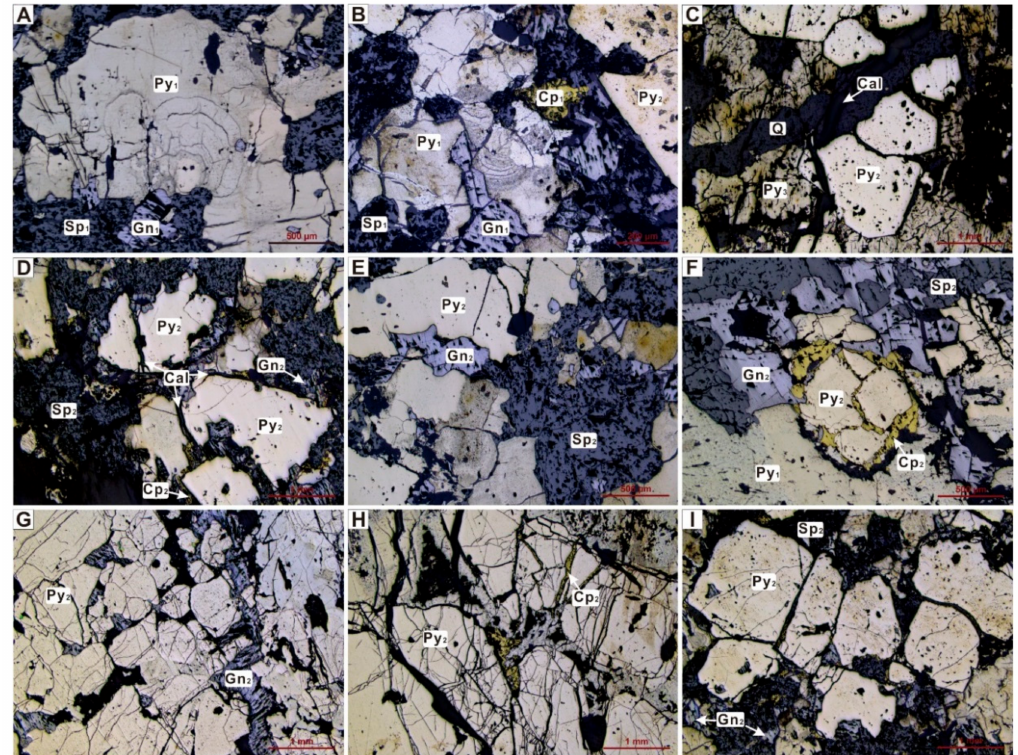
Figure 6. Mineral assemblages and textures of the stratabound ores. ( A ) Colloform pyrite replaced by sphalerite and galena. ( B ) Colloform pyrite replaced by sphalerite, chalcopyrite and galena. ( C ) Euhedral coarse grain pyrite crosscuts by quartz and calcite. ( D ) Euhedral pyrite replaced by sphalerite and galena, and chalcopyrite fills the fractures of pyrite. ( E ) galena and sphalerite replaced by pyrite. ( F ) Chalcopyrite filling in fracture of pyrite. ( G ) Coarse-grain pyrite crosscut by galena vein. ( H ) Chalcopyrite veinlets filling cracks in subhedral pyrite. ( I ) Interstitial filling of galena and sphalerite in subhedral pyrite. All microphotographs were taken under reflected plane-polarized light. Mineral abbreviations: Cal = calcite, Py = pyrite, Sp = sphalerite, Gn = galena, Cp = chalcopyrite, Cal = calcite, Q =